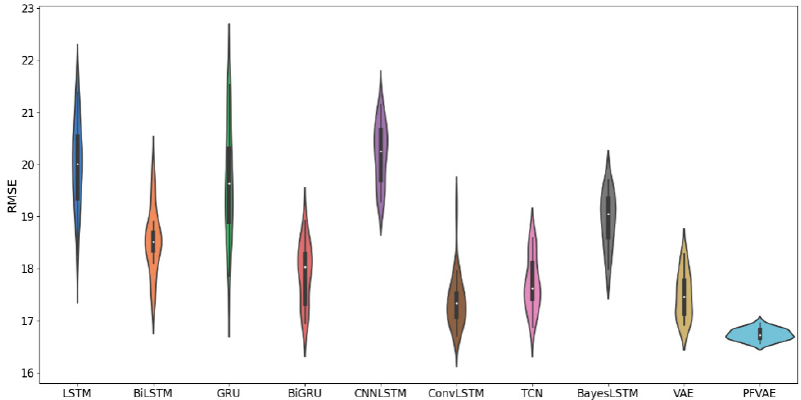
Figure 10. RMSE violin plots for each model run 20 times on the humidity dataset.